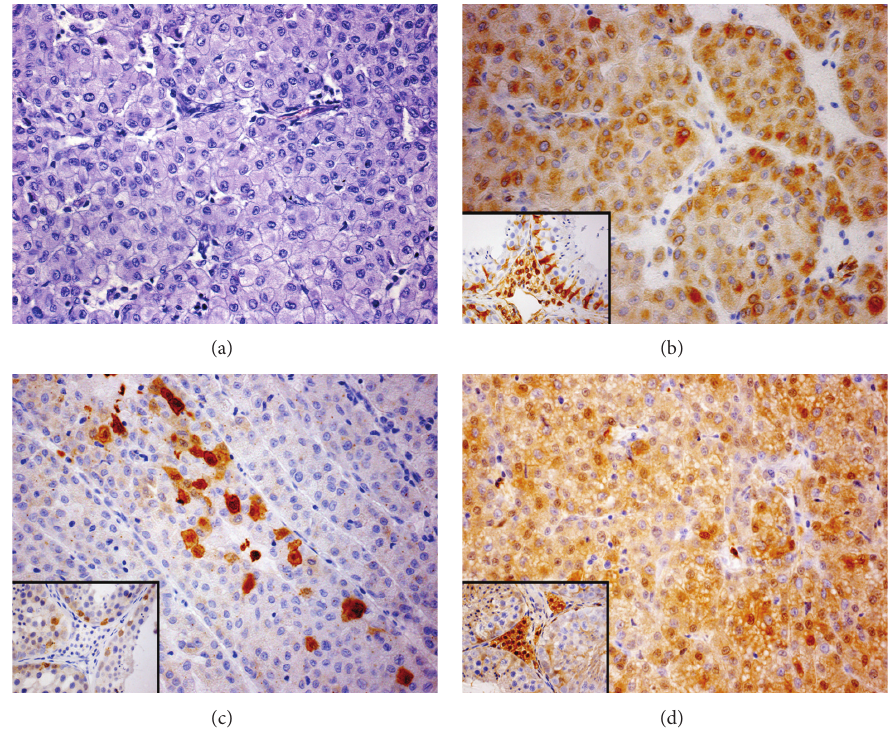
Figure 1: Cat; testis; Leydig cell tumour. (a) Neoplastic polyhedral Leydig cells with a large, eosinophilic, and vacuolated cytoplasm and a small and dark nuclei. These cells are arranged in solid sheets surrounded by a fine connective stroma in which a vascular structure can be observed. Hematoxylin and Eosin stain, × 40. (b) Diffuse cytoplasmic immunoreactivity of neoplastic cells to vimentin. Biotin-streptavidin- peroxidase method and hematoxylin counterstain. × 40. (c) Weak immunolabeling of tumour cells to calretinin antibody with some foci of strong intensity. Biotin-streptavidin-peroxidase method and hematoxylin counterstain. × 40. (d) Diffuse immunolabeling of neoplastic cells to melan-A antibody. Biotin-streptavidin-peroxidase method and hematoxylin counterstain. × 40. Inserts: immunolabeling in normal testicular tissue to the respective markers.